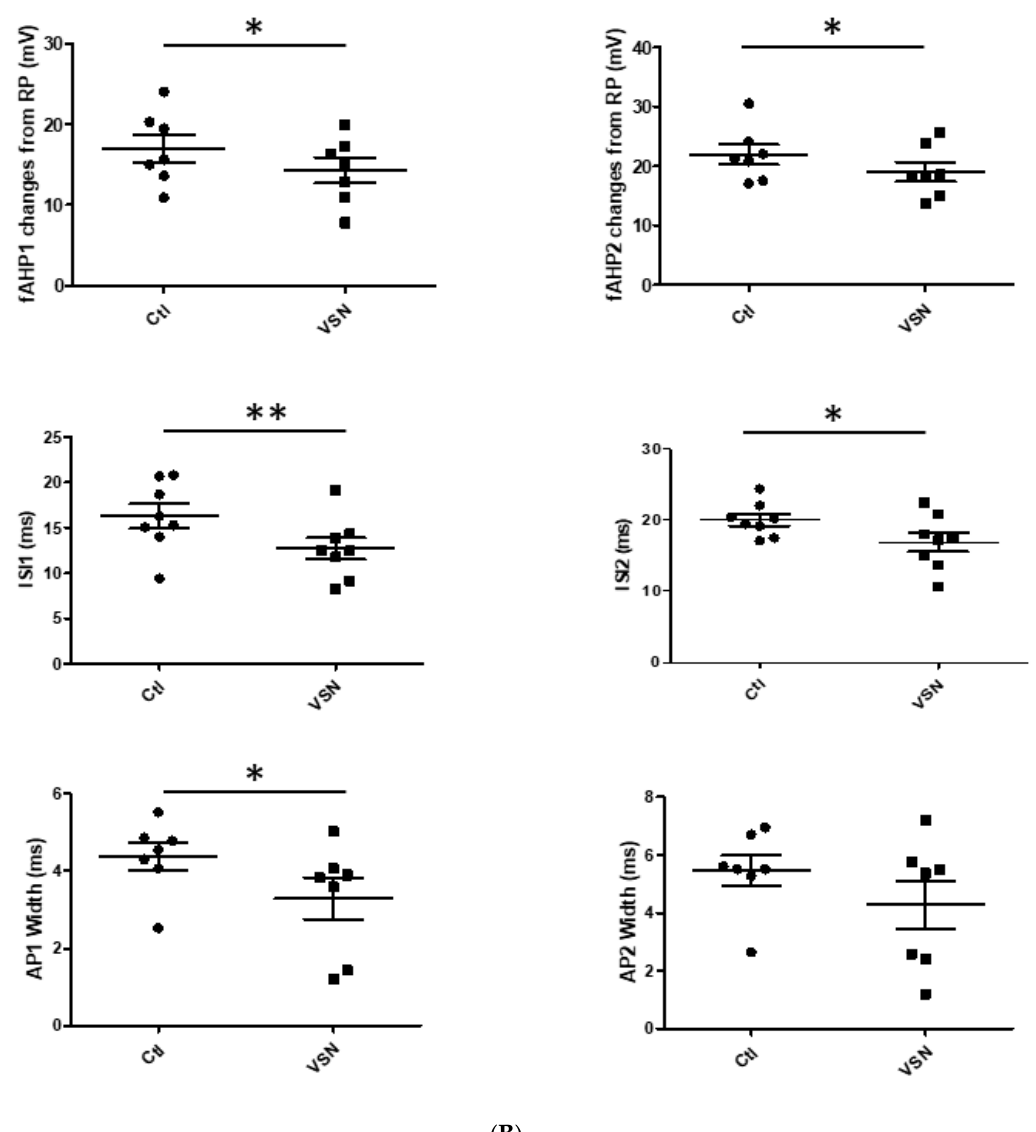
Figure 1. Effect of VSN16R on AP waveform under high frequency stimulus. ( A ) Exemplar trace showing effects of 100 μ M VSN16R. ( B ) Effects before (control) and at steady state after application of 100 μ M VSN16R on absolute change of first and second fAHP amplitude from resting potential, first and second ISI and first and second AP width. Data from n = 7 cells; * = P < 0.05; ** = P < 0.01. 3.2. VSN16R Effects are Blocked by IBTX, but Effects Persist, or are Uncovered, in the Presence of 7-Pra- MarTx